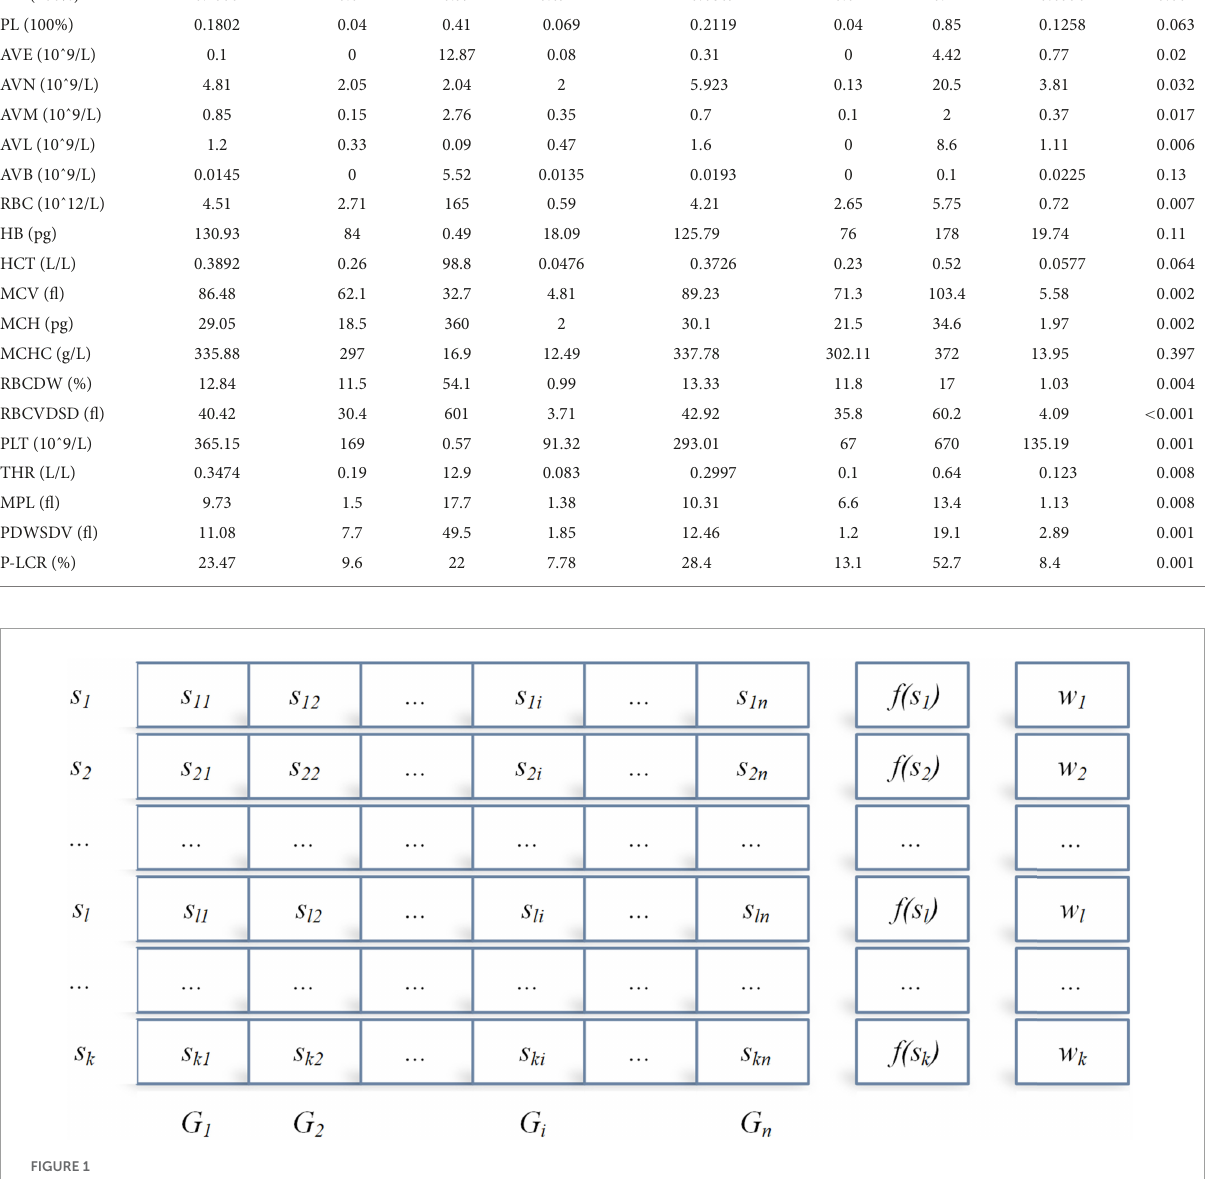
FIGURE1 The archive of solutions in